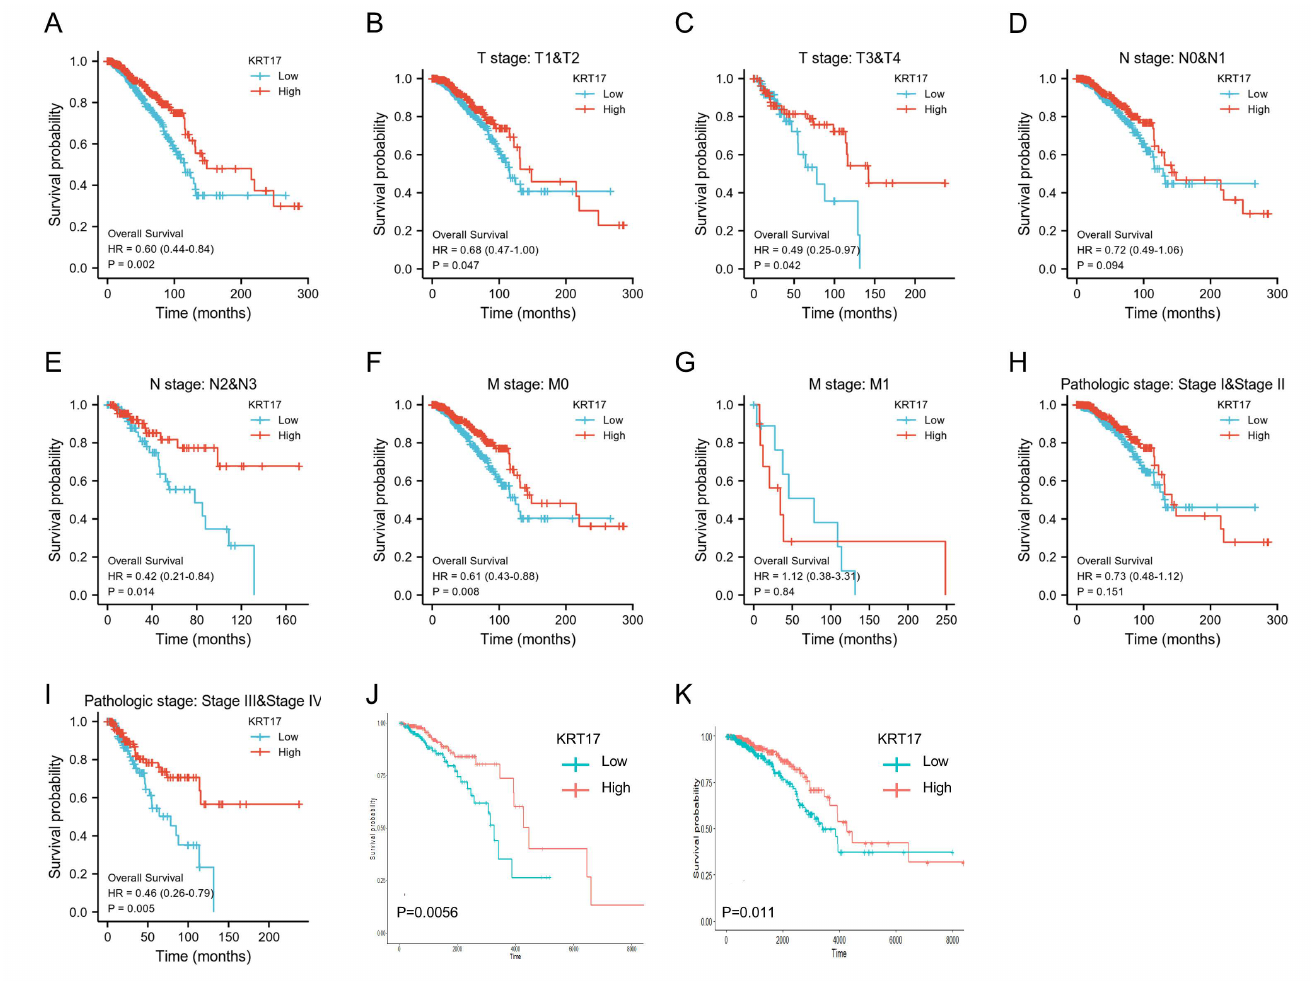
Figure 2. Predictive value of KRT17 in BC. Kaplan–Meier curves were used to compare overall survival (OS) in the KRT17 high and KRT17 low groups of BC patients: ( A ) OS of the BC cohort based on KRT17 expression, ( B ) T stage (T1–T2), ( C ) T stage (T3–T4), ( D ) N stage (N0–N1), ( E ) N stage (N2–N3), ( F ) M stage (M0), ( G ) M stage (M1), ( H ) pathological stage (I–II), and ( I ) pathological stage (III-IV). ( J , K ) The relationship between KRT17 expression and OS in ( J ) HER2 high and ( K ) HER2 low BC